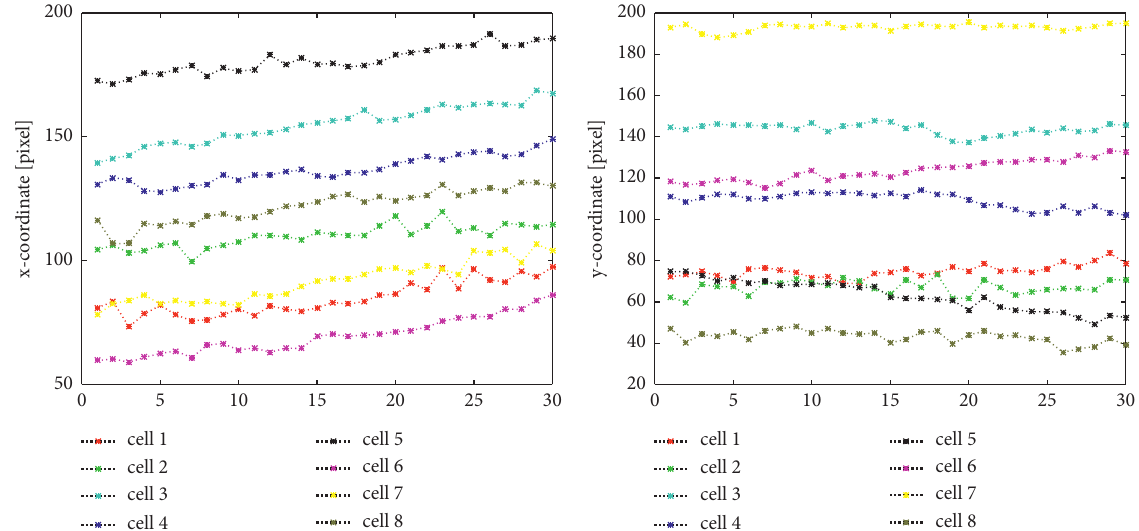
Figure 9: Position estimation of each cell in x and y coordinates.